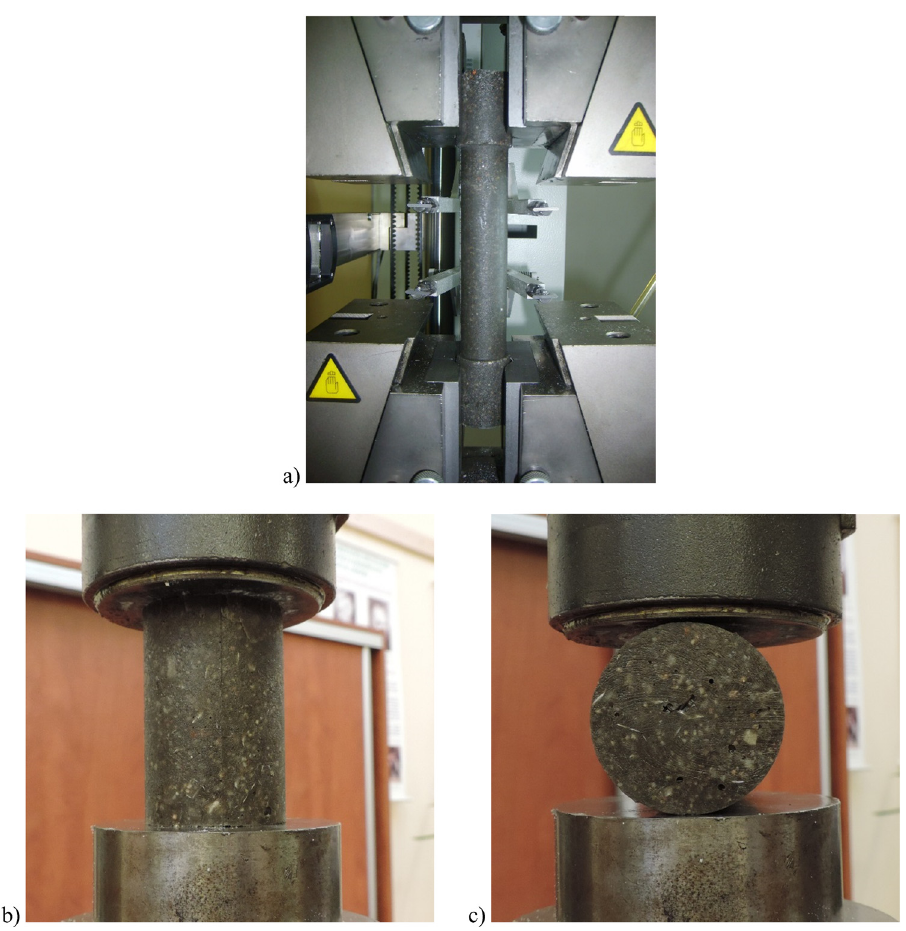
Figure 2: Views of specimens mounted in measuring apparatus ( a ) for tensile strength, ( b ) for compressive strength, ( c ) for splitting tensile